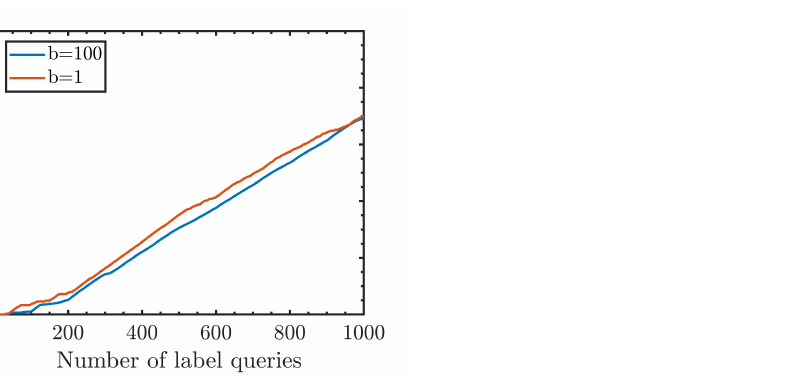
Figure 7. Active target detection in the EC mechanism combinatorial search space (see Table 1 for definition of search space). We repeat the active search 20 times, each time starting with a randomly chosen non-S-shape data point in S